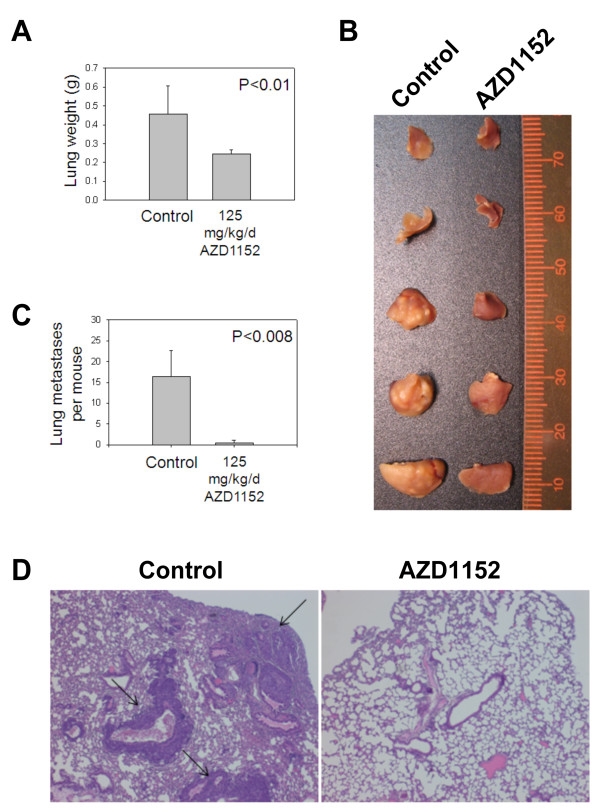
AZD1152 inhibits growth of lung tumor nodules in a lung metastasis nude mouse model. (A) Two million MDA-MB-231 human breast cancer cells were injected via tail veins of nude mice. AZD1152 (125 mg/kg/dose) or vehicle were administered IP on days 1 and 2 of 7-day repeating cycle for 4 cycles starting 2 days after cancer cell injection. Ten weeks after cancer cell injection, the mice were sacrificed and lungs were weighed and plotted as the means for each treatment group. (B) Matched lobes of the lungs from a representative mouse from each group are shown as labeled. (C) The number of macroscopic tumor nodules in the lungs was counted in each mouse. The mean number of nodules per mouse was plotted for each group. Error bars represent 95% confidence intervals. (D) H&E stained slides of lungs from control and drug treated mice are shown at the same magnification. Arrows indicate metastatic lung tumors.